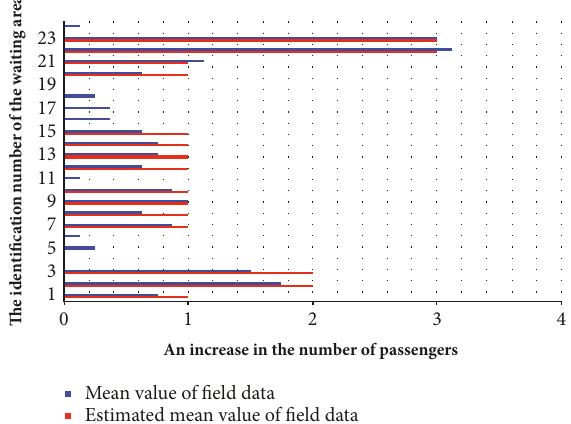
Figure 10: An increase in the field number of passengers at each waiting area 𝑁 𝑤 𝑖𝑛𝑐𝑟𝑒𝑎𝑠𝑒 with Anheqiao North direction.